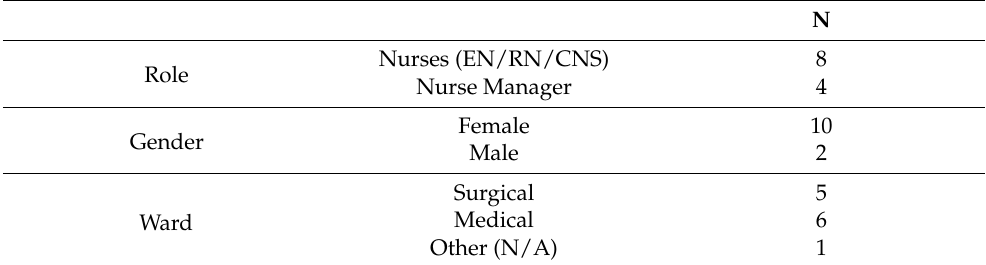
Table 1. Demographics of participants.